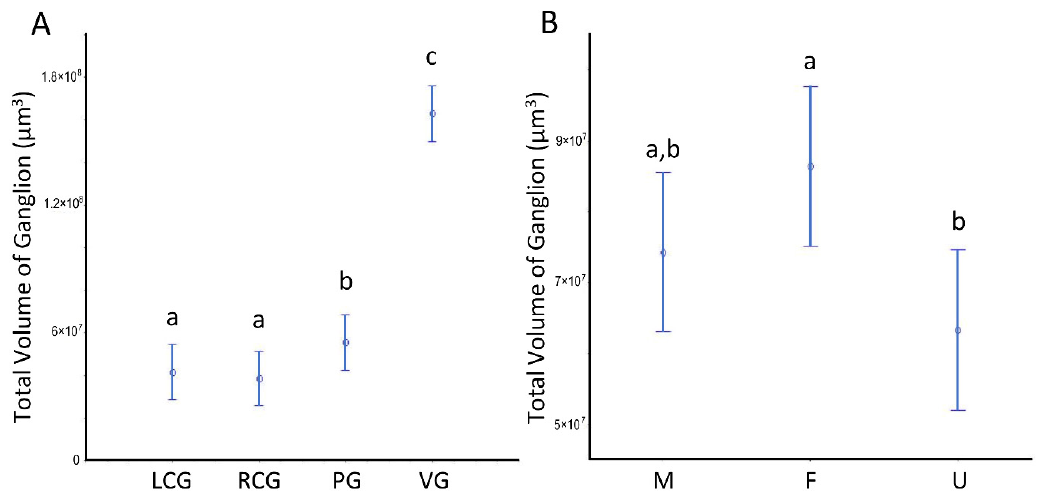
Figure 5. Volumes of the ganglia of S. plana . ( A ) Per ganglion. ( B ) All ganglia per sex condition. Different letters mean significant differences ( p < 0.05). Data as mean and 95% confidence interval. LCG: left cerebral ganglion; RCG: right cerebral ganglion; PG: pedal ganglion; VG: visceral ganglion; M: males; F: females; U: undifferentiated. Six animals per sex condition were used.